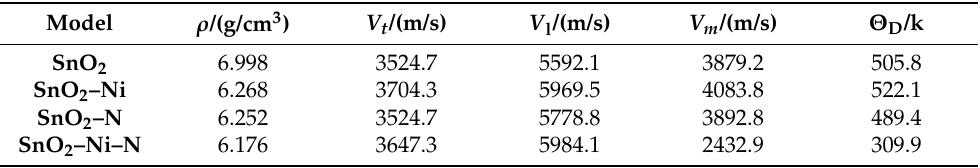
Table 5. Density ρ /(g/cm 3 ), transverse wave velocity V t /(m/s), longitudinal wave velocity V l /(m/s), average wave velocity V m /(m/s) and Debye temperature Θ D /k.